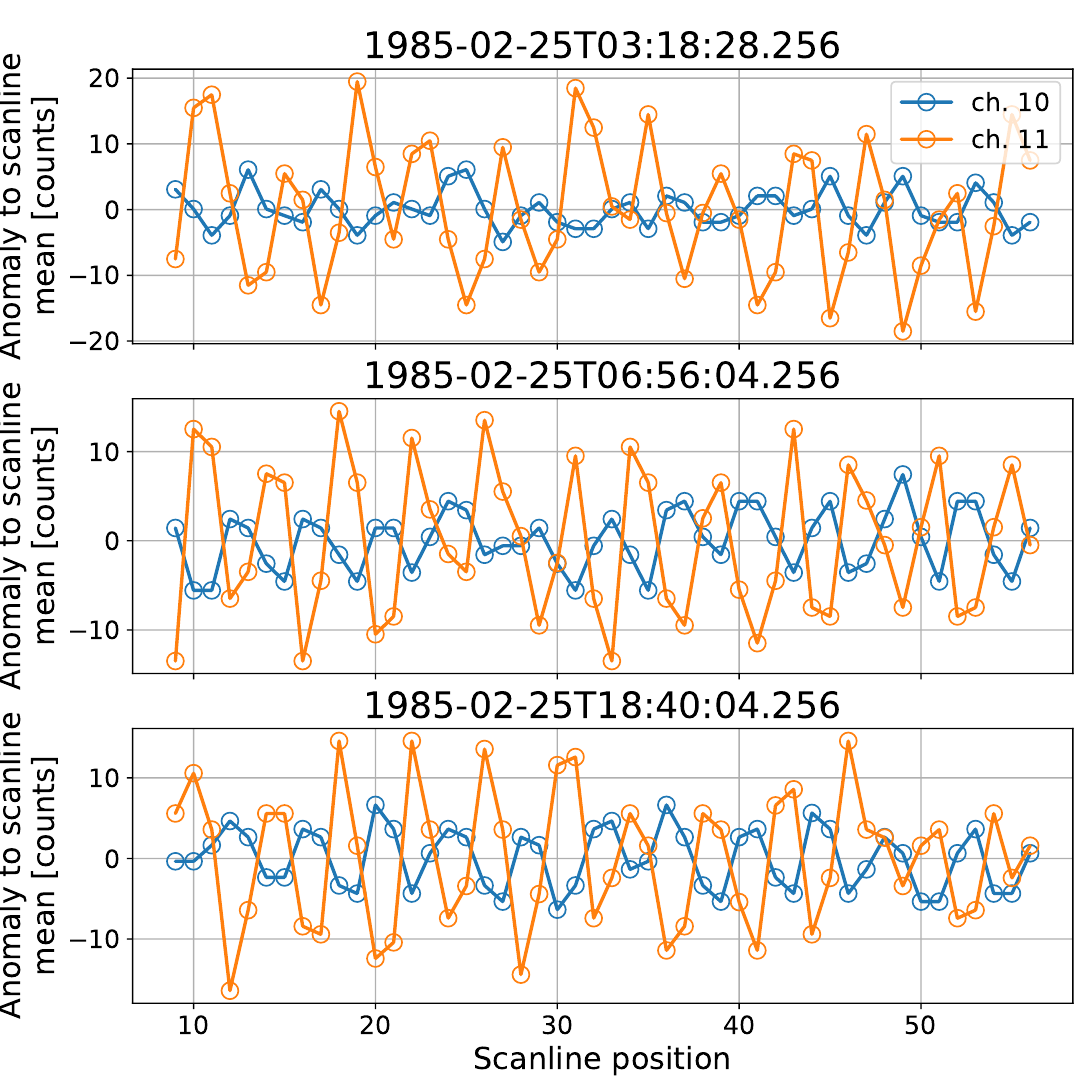
Figure 3. Example of space view deviations for three sets of calibration measurements for two channels on